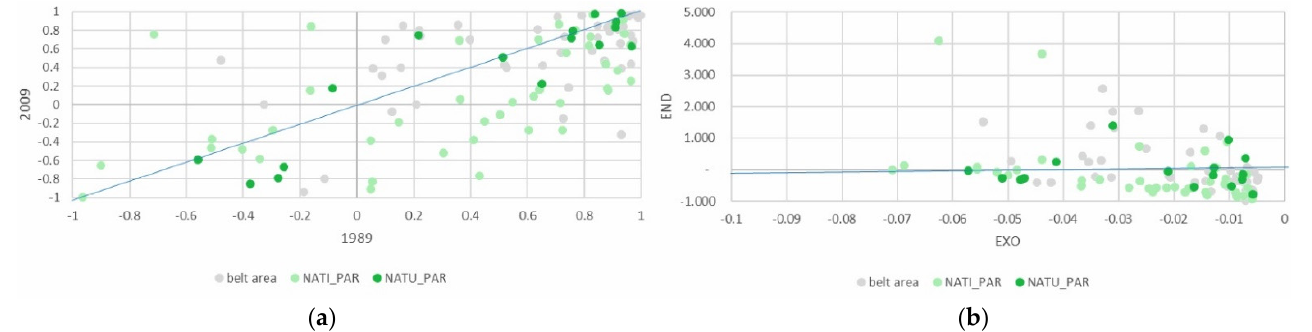
Figure 5. ( a , b ) Sierra Nevada- PSI and DPSI for fruit tree cultivation. Source: Drawn up by the authors using data from the 1989 and 2009 Agrarian Censuses, Ministry of Agriculture.